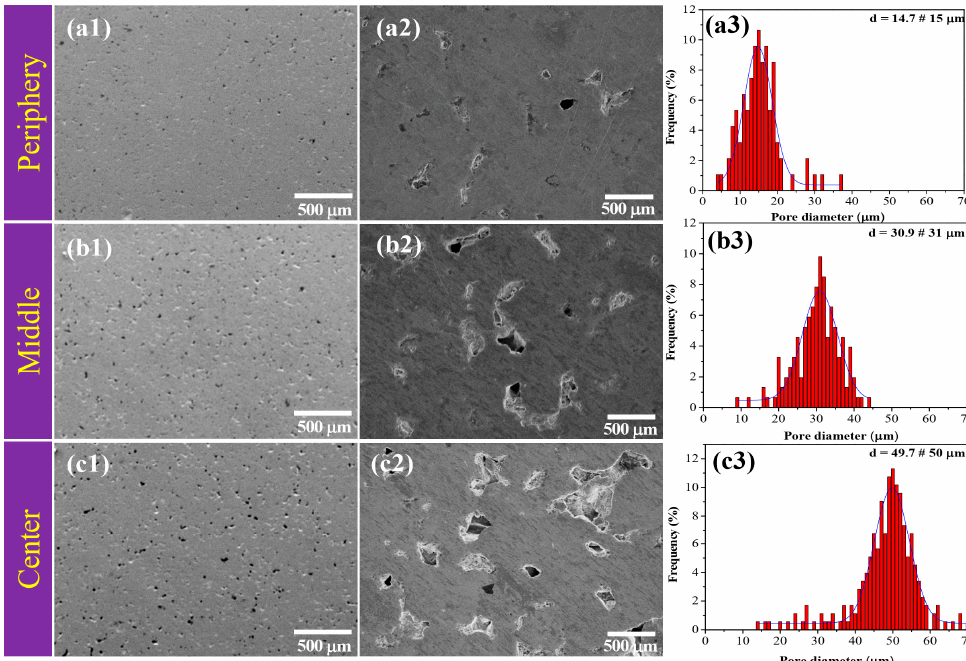
Figure 4. SEM images and pore size distribution of Ti6Al4V alloy sintered by capsule-free at different positions: ( a1 , a2 , a3 ) periphery, ( b1 , b2 , b3 ) middle, and ( c1 , c2 , c3 ) center of the specimen.